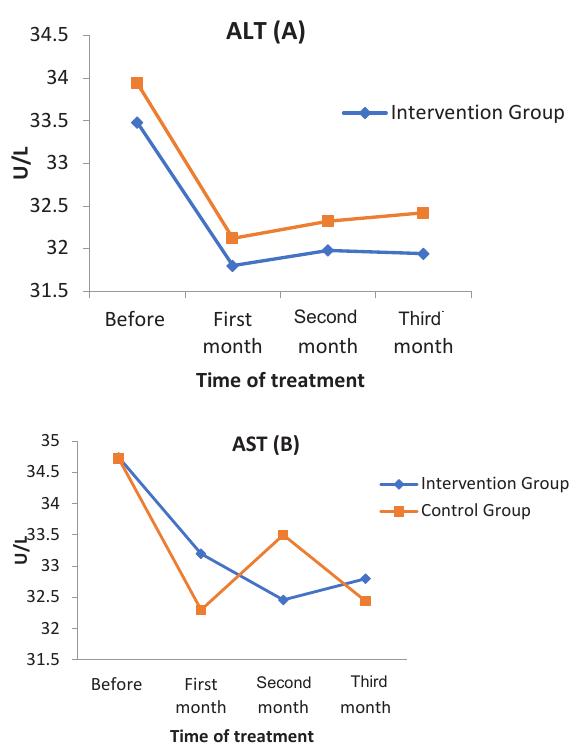
Figure 2. Mean of liver enzymes at the time of interventions (before, first, second, and third month after the treatment) between control and intervention groups. Note . ALT: Alkaline aminotransferase; AST: Aspartate